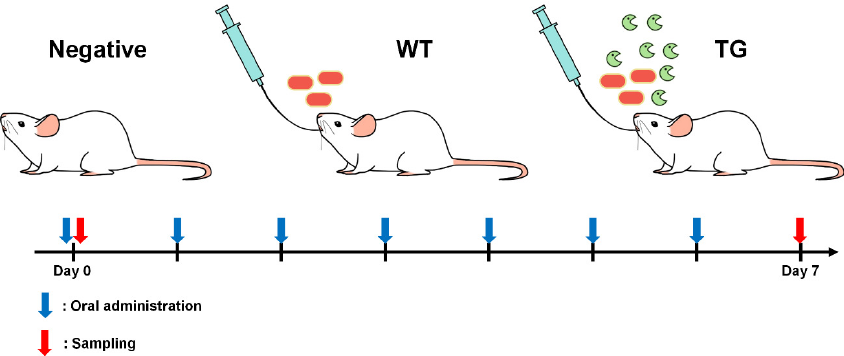
Figure 1. Experimental scheme of sample preparation for metagenomic study. Three different conditions were used: negative, WT, and TG. Syringes indicate normal oral administration. Orange rods and green shapes indicate Lactobacillus and Lactobacillus expressing 3D8 scFv, respectively. Blue arrows indicate time points for oral administration while red arrows indicate sampling time points of day 0 and day 7. WT: Wildtype; TG: Transgenic